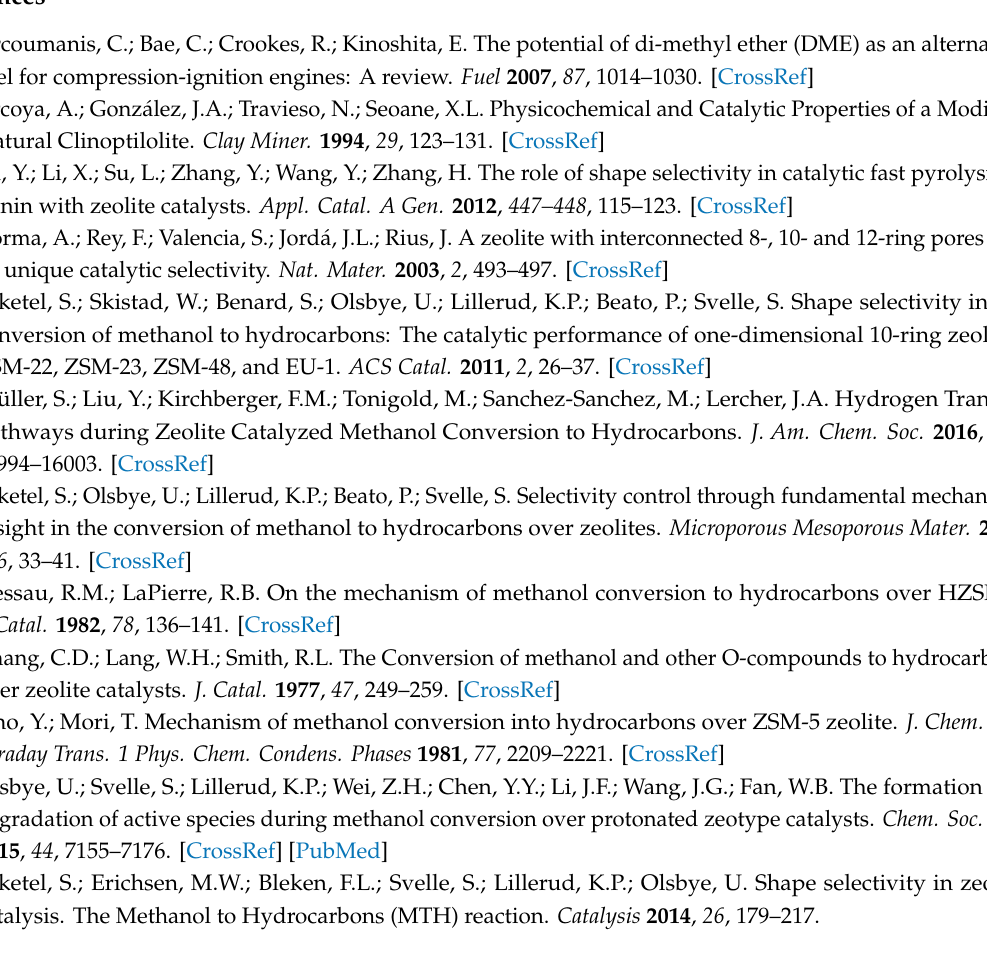
Figure S1: Plots of contact auto-correlation function for the H-Beta (a) 2 mpuc with (b) 4 mpuc and H-MFI (c) 3 mpuc with (d) 5 mpuc models calculating the residence time of methanol molecules at the Brønsted acid site. The curves represent the exponential fitting for the simulation